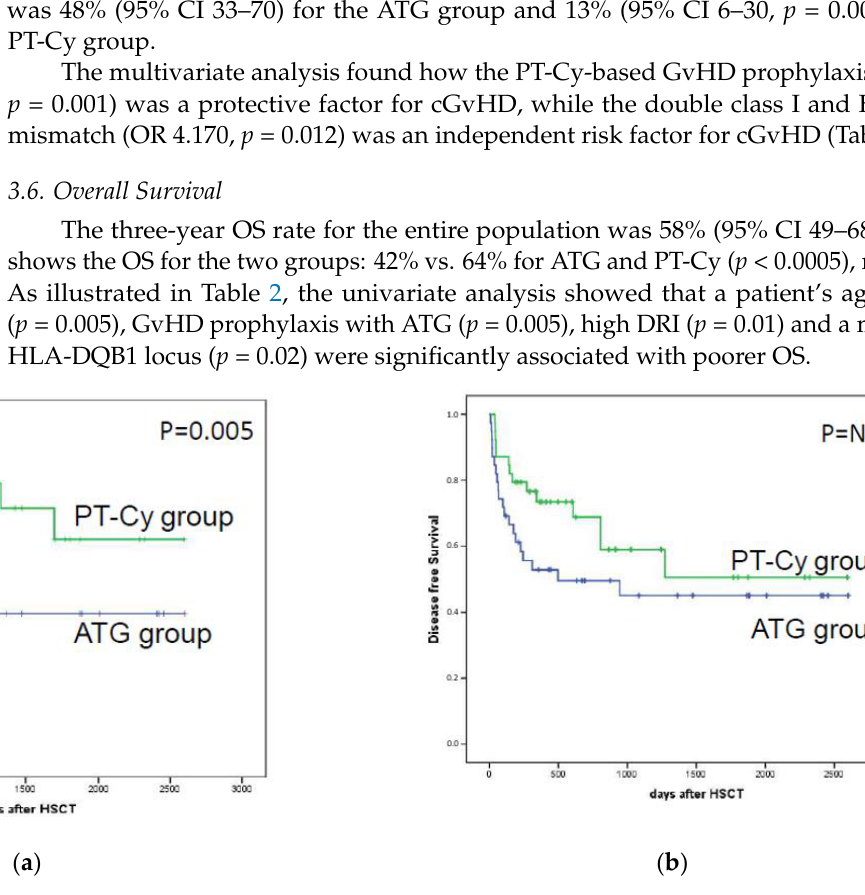
Figure 3. Comparison of the overall survival and disease-free survival of the patients treated with ATG (blue line) and the patients treated with PT-Cy (green line). In ( a ), the overall survival after mismatched unrelated donor transplantation underlined a significant result for the PT-Cy group; ( b ) shows progression-free survival after mismatched unrelated donor transplantation with a non- significant p value.